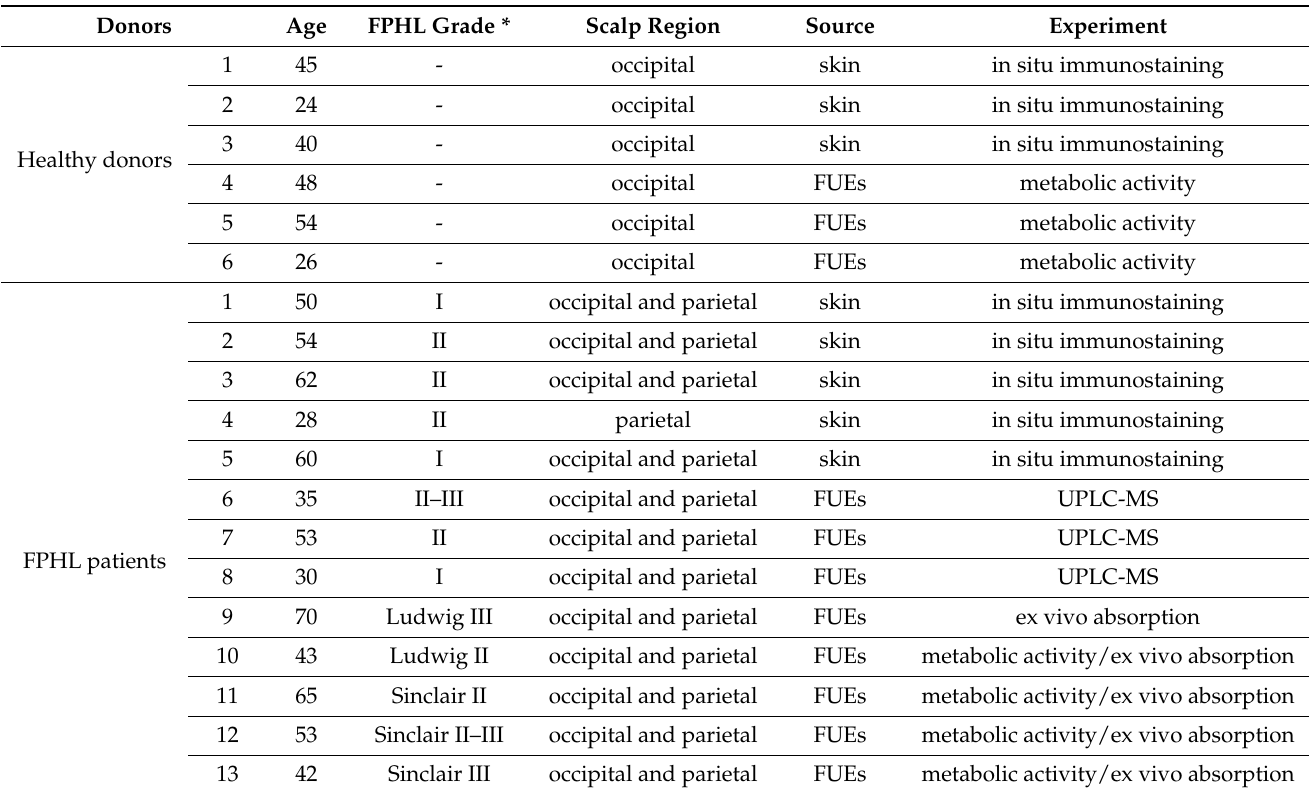
Table 1. Overview of clinical samples used for the